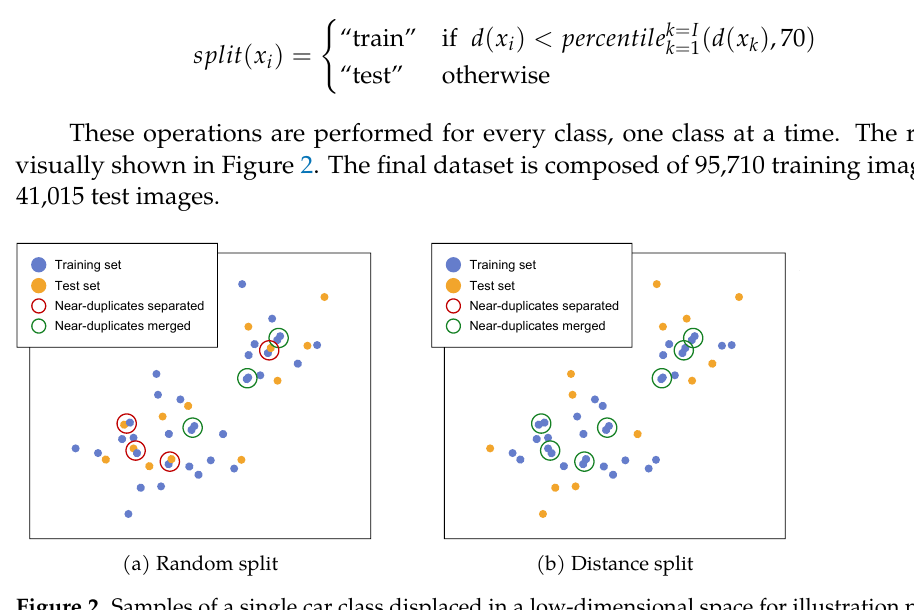
Figure 2. Samples of a single car class displaced in a low-dimensional space for illustration purposes. A random training/test split ( a ) might separate near duplicates between training and test set, thus creating a bias. A split based on visual distance ( b ) ensures that groups of instances that are too similar remain in the training set, resulting in a more challenging and realistic test